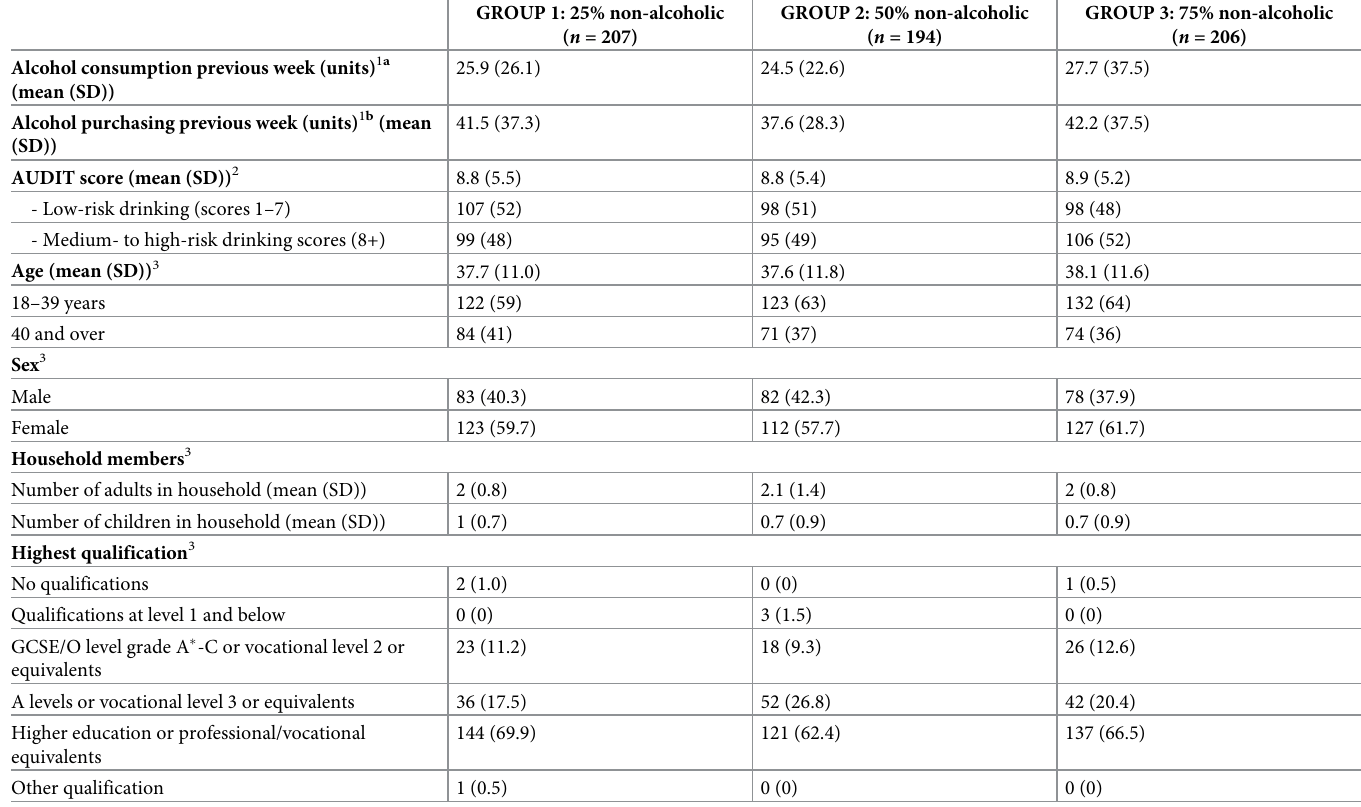
Table 1. Characteristics of participants included in primary outcome analysis (n (%), unless otherwise